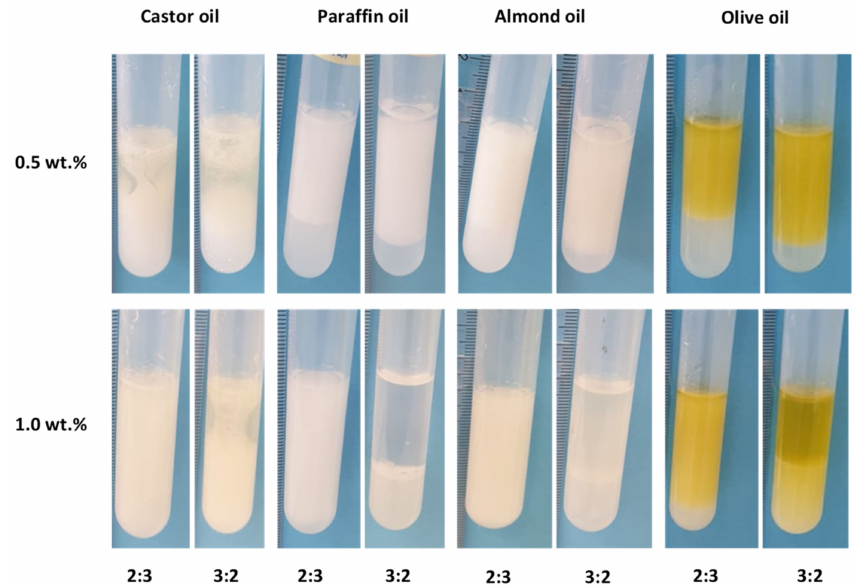
Figure 2. Emulsions prepared with FucoPol (0.5 or 1.0 wt.%) with castor oil, paraffin oil, almond oil, and olive oil, at o:w weight ratios of 2:3 and